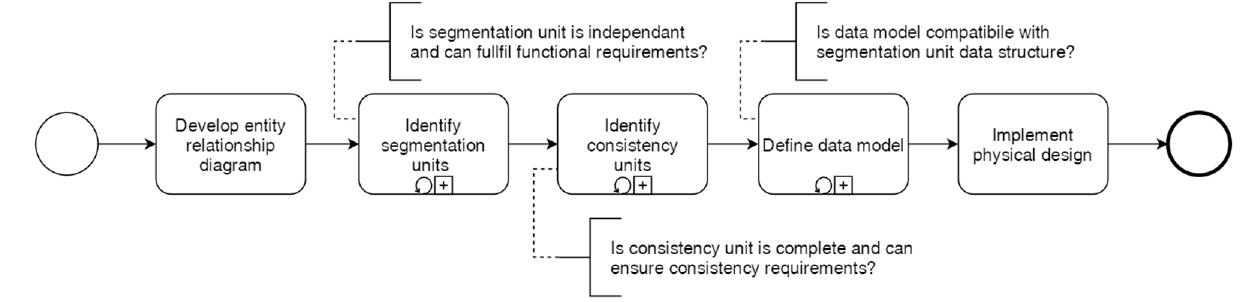
Figure 3. The data model development.